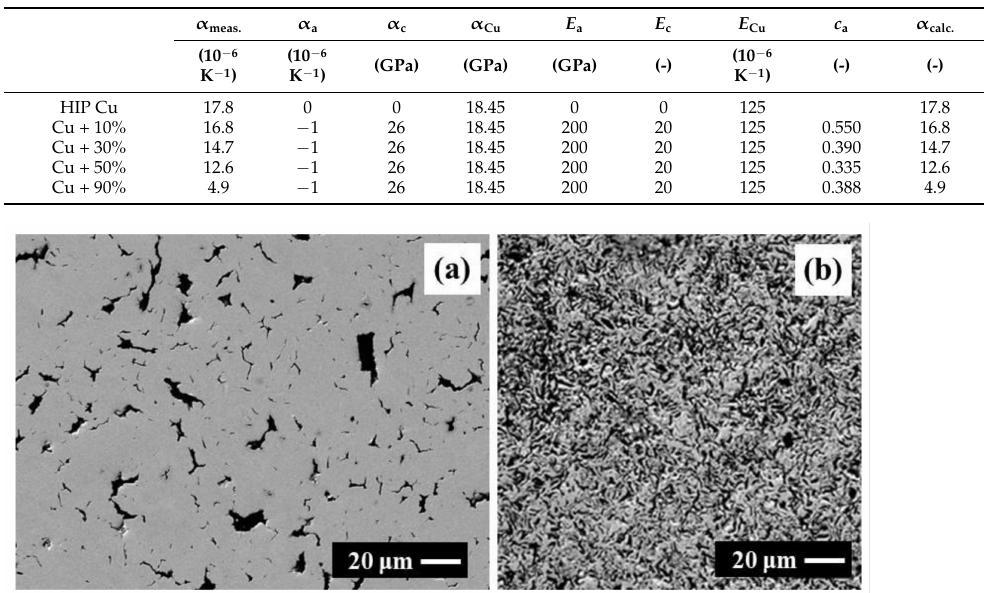
Figure 10. SEM images of the Cu–graphite composites. Cu are colored in light grey, and graphite is colored in black: ( a )—uncoated graphite at 10 vol. % graphite; ( b ) [37]—coated graphite at 50 vol. % graphite.